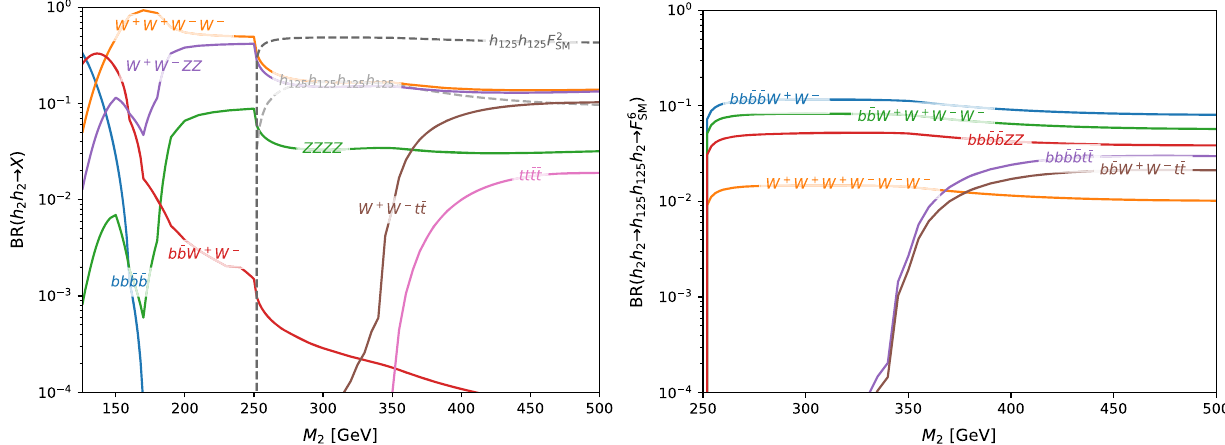
Fig. 15 Branching ratios of the h 2 h 2 state of BP6 . The left panel con- tains a selection of final states from direct decays of h 2 → F SM and (inclusive) decays involving h 2 → h 125 h 125 (both single and double